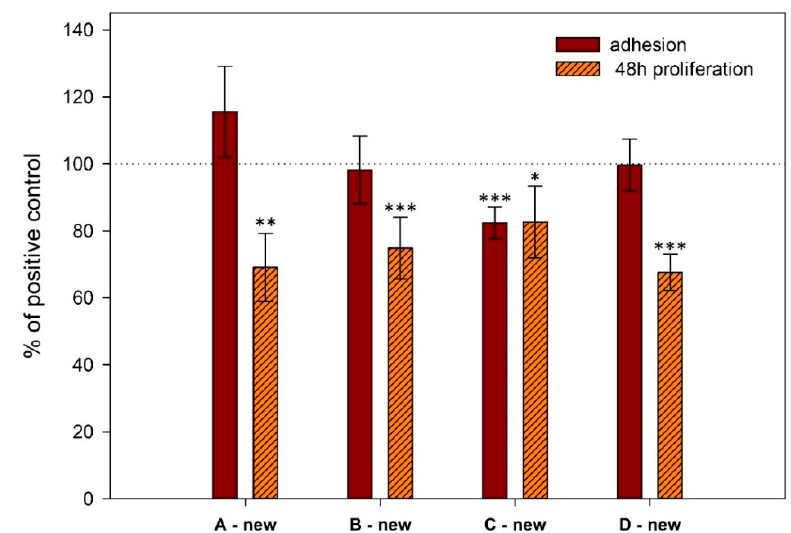
Figure 3. Comparison of cell adhesion and proliferation on the surface of new titanium samples assessed by CCK-8 assay in four independent experiments. The standard errors were calculated from five replicates. Data expressed as a percentage of positive control. Error bars indicate means ± standard deviations. Asterisks above the bars indicate significant differences (* p < 0.05, ** p < 0.01, *** p < 0.001) between titanium samples and positive controls.